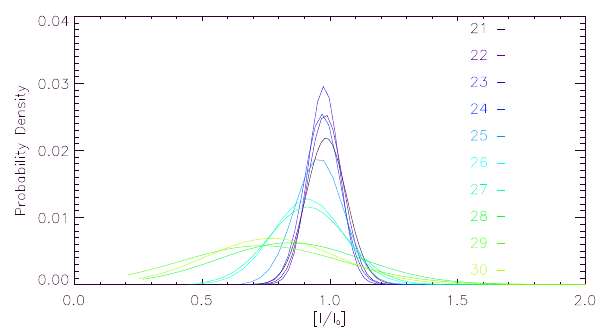
Figure 8 The normalized intensity distribution for a period of 10 seconds starting at 07:22:10 UTC (10 times 1 second).